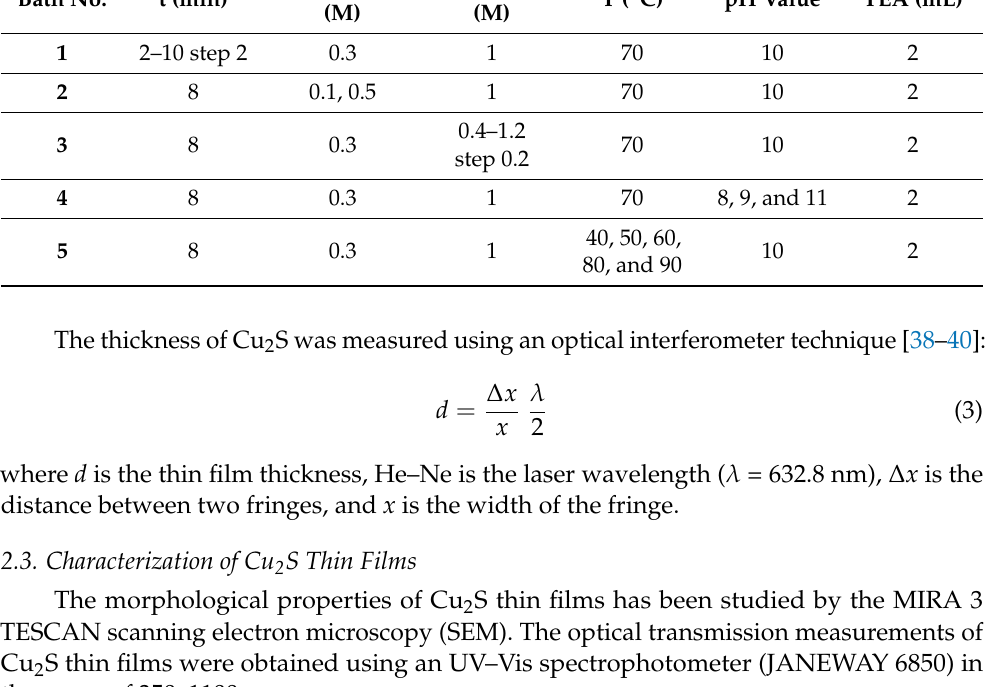
Table 1. Chemical bath solutions. Bath